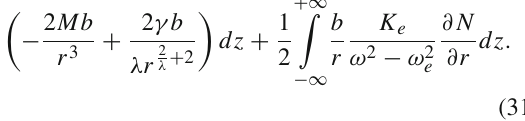
and for the values λ = 2 / 3 and γ = β( 2 M ) 3 one